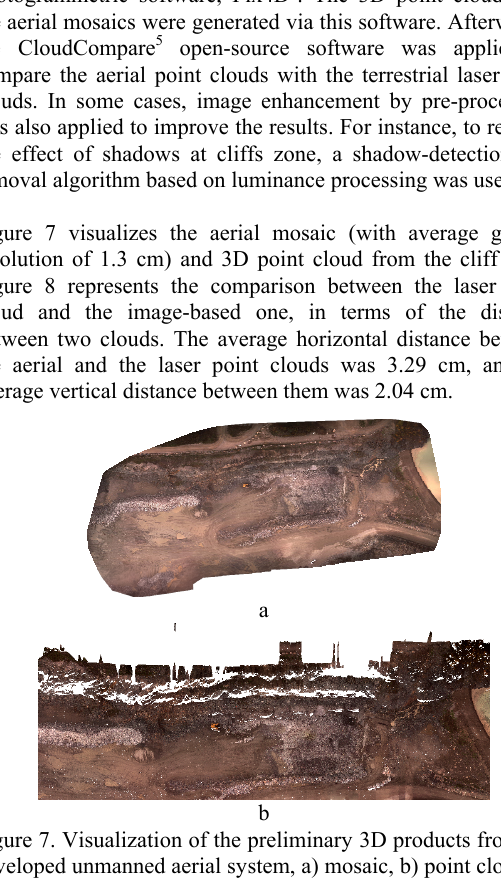
Figure 6. Fieldwork elements, a) Configuration of GCPs and VX scanner stations for the cliffs zone, b) signalized target patterns for GCPs